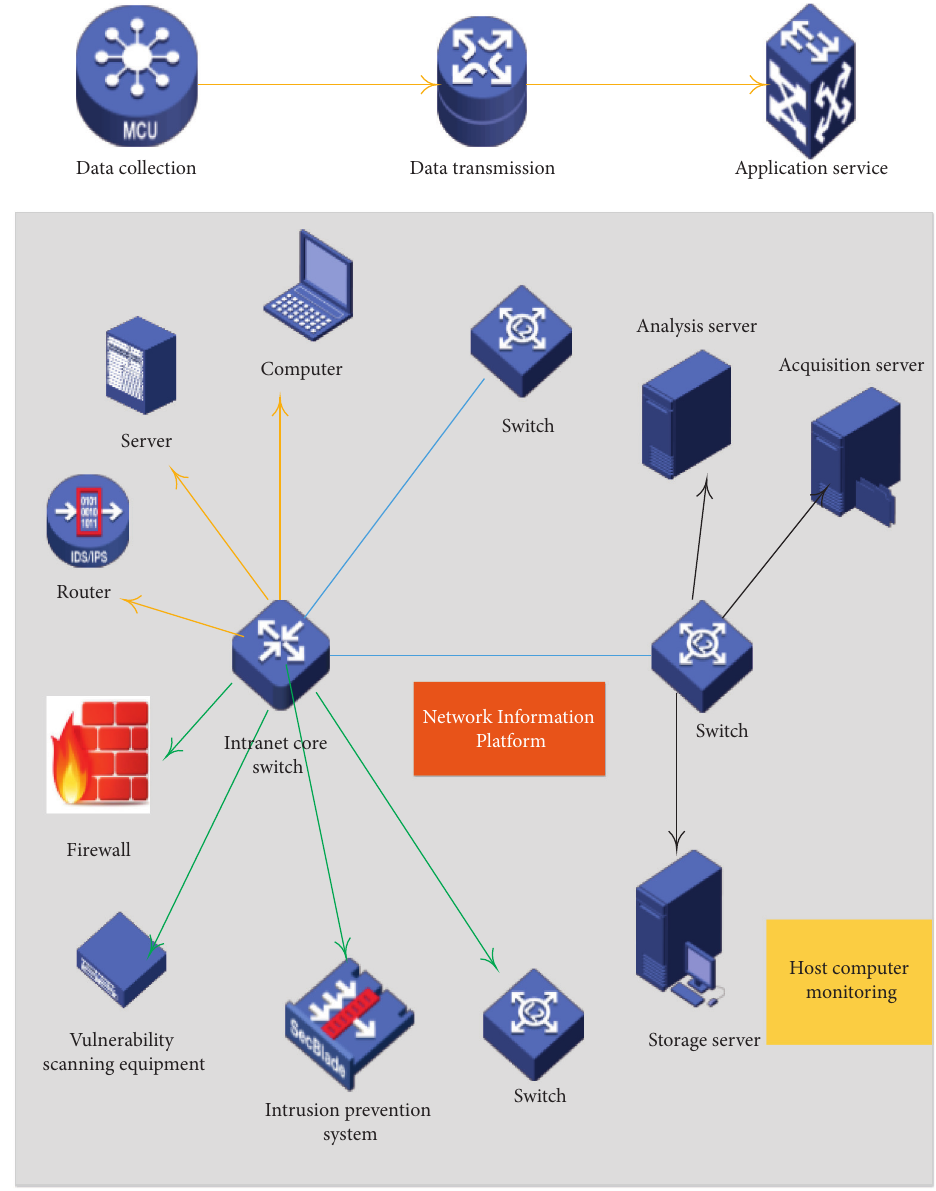
Figure 2: Wireless monitoring system